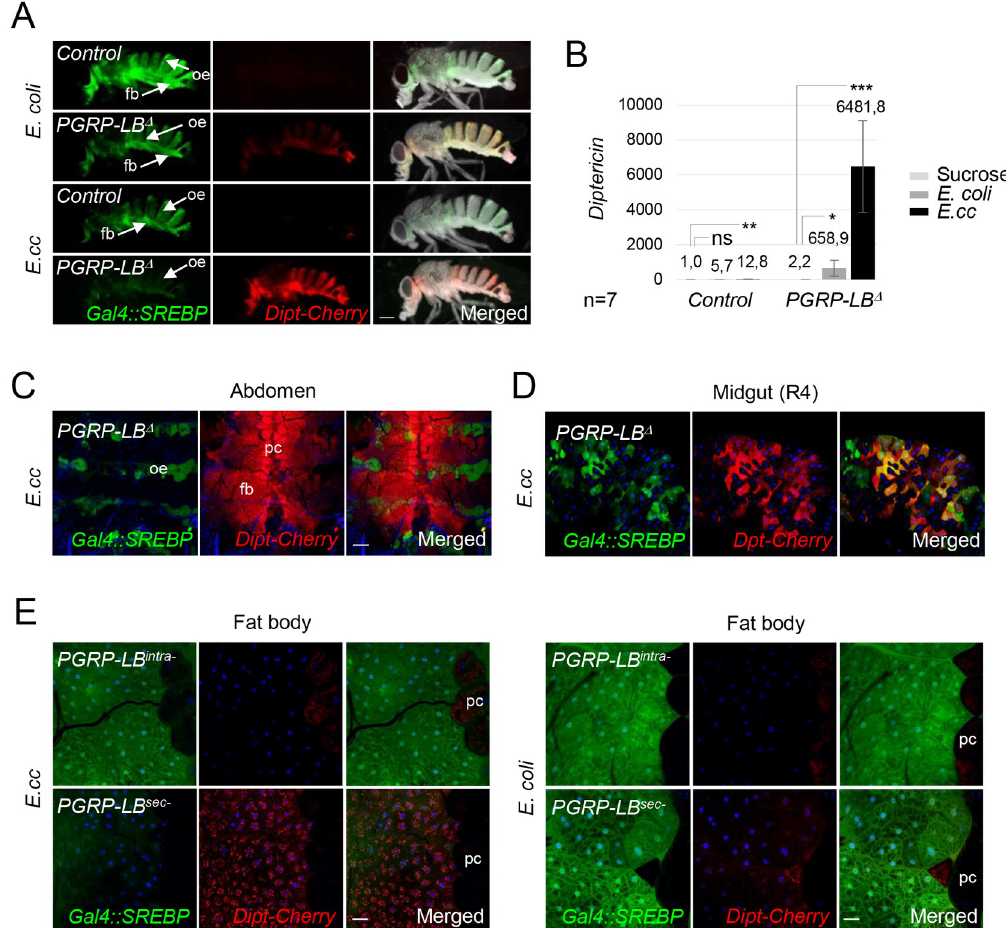
Fig 4. Bacteria-dependent gut-born PGN antagonizes SREBP activation in adipocytes. (A) Pictures of adult flies, control or PGRP-LB Δ mutants, fed 8 days with a mixture of sucrose + E . coli or E . cc , and showing Dipt-Cherry expression (red) and Gal4 :: SREBP activation (green). E . coli feeding promotes activation of Gal4 :: SREBP in fat bodies from control and PGRP-LB Δ mutant. Ingestion of E . cc , however, triggers activation of Gal4 :: SREBP in fat body from control flies, but not from PGRP-LB Δ mutant’s flies. As expected, activation of Dipt-Cherry is observed in fat body from PGRP-LB Δ mutants fed with bacteria. The constitutive activation of Gal4 :: SREBP in oenocytes is indicated (oe arrows). Flies of the following genotypes were used: w 1118 /w 1118 ; Gal4 :: SREBP , UAS-2XEGFP/+; Dipt-Cherry C1 /Dipt-Cherry C1 ( Control ) and w 1118 /w 1118 ; Gal4 :: SREBP , UAS-2XEGFP/+; Dipt- Cherry C1 , PGRP-LB Δ /Dipt-Cherry C1 , PGRP-LB Δ ( PGRP-LB Δ ). (B) Histograms showing the expression of Diptericin measured by q-RT-PCR and performed with mRNA extracted from adult abdominal carcasses of control adults fed 4 days with either sucrose, on with a mixture of sucrose + bacteria ( E . coli or E . cc ). The mRNA level in non-infected control flies was set to 1 and values obtained with indicated genotypes were expressed as a fold of this value. Histograms correspond to the mean value ± SD of seven experiments (n = 7). � p < 0.05, �� p < 0.01, ��� p < 0.001; Kruskal-Wallis test. Flies of the following genotypes were used: w 1118 /w 1118 ;; Dipt-Cherry C1 /Dipt-Cherry C1 ( Control ) and w 1118 /w 1118 ;; PGRP-LB Δ , Dipt-Cherry C1 /PGRP-LB Δ , Dipt-Cherry C1 ( PGRP-LB Δ ). (C-D) Confocal images of the dorsal part of adult abdominal carcasses viewed from inside (C) or of the midgut R4 domain (D) from PGRP-LB Δ mutant flies fed with E . cc , showing Dipt-Cherry expression (red) and Gal4 :: SREBP activation (green). Adipocytes from PGRP-LB Δ mutant flies display high level of Dipt-Cherry expression but no activation of Gal4 :: SREBP . Constitutive expression of Dipt-Cherry in pericardial cells and activation Gal4 :: SREBP in oenocytes are indicated (C). Enterocytes of PGRP-LB Δ mutant flies display activation of both reporters (D). Flies of the following genotypes were used: w 1118 /w 1118 ; Gal4 :: SREBP , UAS-2XEGFP/+; Dipt-Cherry C1 , PGRP-LB Δ /Dipt-Cherry C1 , PGRP-LB Δ ( PGRP-LB Δ ). (E) Confocal images of adult fat body from CRISPR mutant flies PGRP-LB intra- or PGRP-LB sec- , fed 72h with E . cc (A) or E . coli (B) and showing Dipt-Cherry expression (red) and Gal4 :: SREBP activation (green). (A) E . cc feeding induces activation of Dipt-Cherry in adipocytes from PGRP-LB sec- animals, but not from PGRP-LB intra- ones. Gal4 :: SREBP activation is faint in the CRISPR- specific mutant allele PGRP-LB sec -and strong in the PGRP-LB intra -one. (B) E . coli feeding induced a comparable activation of Gal4 :: SREBP in both PGRP-LB sec -or PGRP-LB intra -adipocyte’s mutant flies, but no activation of Dipt-cherry . Flies of the following genotypes were used: w 1118 /w 1118 ;; PGRP-LB PD � Z10e , Dipt-Cherry C1 /PGRP-LB PD � Z10e , Dipt-Cherry C1 ( PGRP-LB intra- ) and w 1118 /w 1118 ;; PGRP-LB PC � 10A , Dipt-Cherry C1 /PGRP-LB PC � 10A , Dipt-Cherry C1 ( PGRP-LB sec- ). pc: pericardial cells. Scale bar is 0,25 mm (A), 100 μ m (C), 50 μ m (D) and 20 μ m (E).